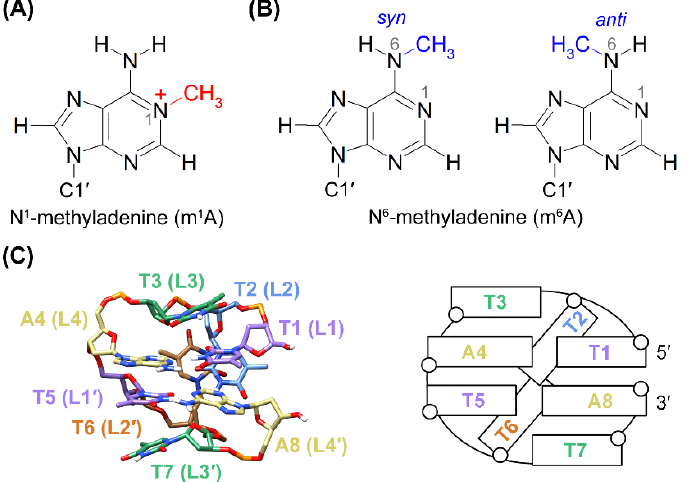
Figure 1. Chemical structures of ( A ) m 1 A, and ( B ) m 6 A with a syn and anti N 6 -methyl conformation, respectively. ( C ) An averaged nuclear magnetic resonance (NMR) solution structure (left) and a schematic secondary structure (right) of the TTTA minidumbbell (MDB) (PDB ID: 5GWQ) [23].